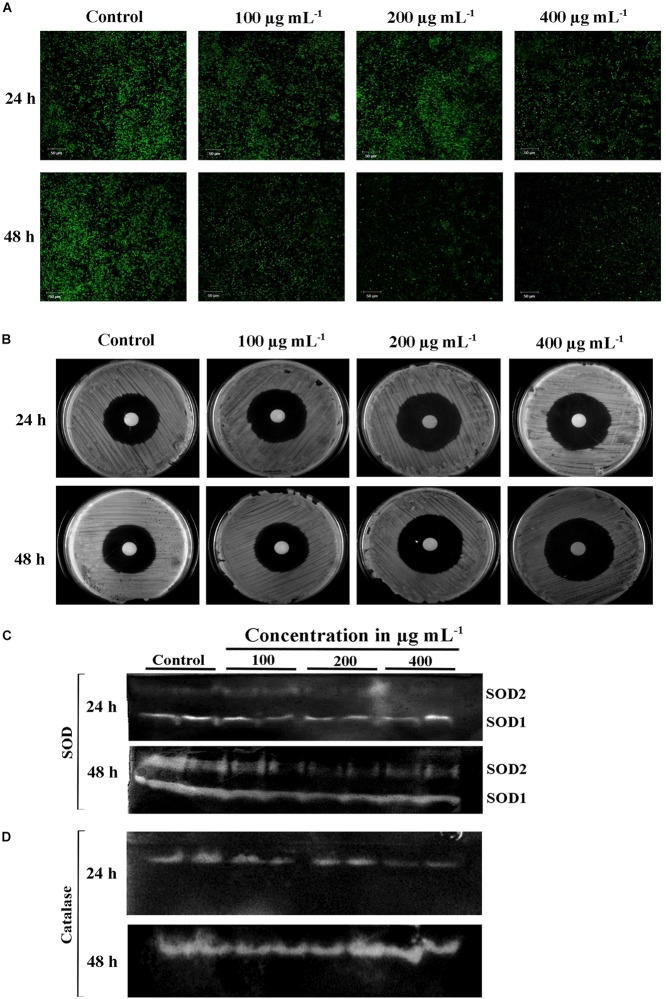
(A) Loss of mitochondrial membrane potential (ΔΨm) in C. tropicalis at different time points (24 and 48 h) and concentrations (100, 200, and 400 μg mL−1) of PA as imaged in CLSM by Rhodamine 123 staining. Presence of PA mediated loss of mitochondrial membrane permeability and induced apoptosis in C. tropicalis.
(B) Representative SDA agar plates depicting the effect of PA on the sensitivity of C. tropicalis to H2O2. Native PAGE revealing expression of superoxide dismutase (SOD) (C) and catalase (D) in PA (0, 100, 200, and 400 μg mL−1) treated C. tropicalis after 24 and 48 h.